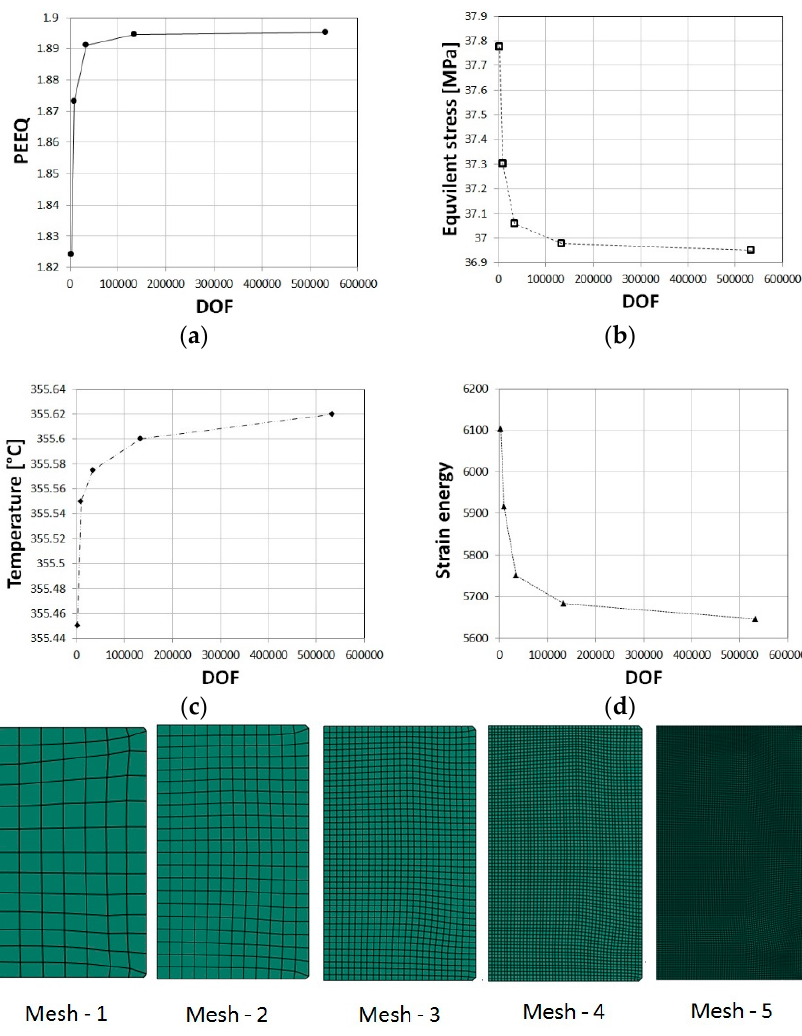
Figure A1. Verification of cylinder upsetting simulations: convergence in equivalent plastic strains ( a ), von-mises stress ( b ), and temperature ( c ). Convergence in strain energy values ( d ). Examples of the specimen mesh used in the convergence study ( e ).